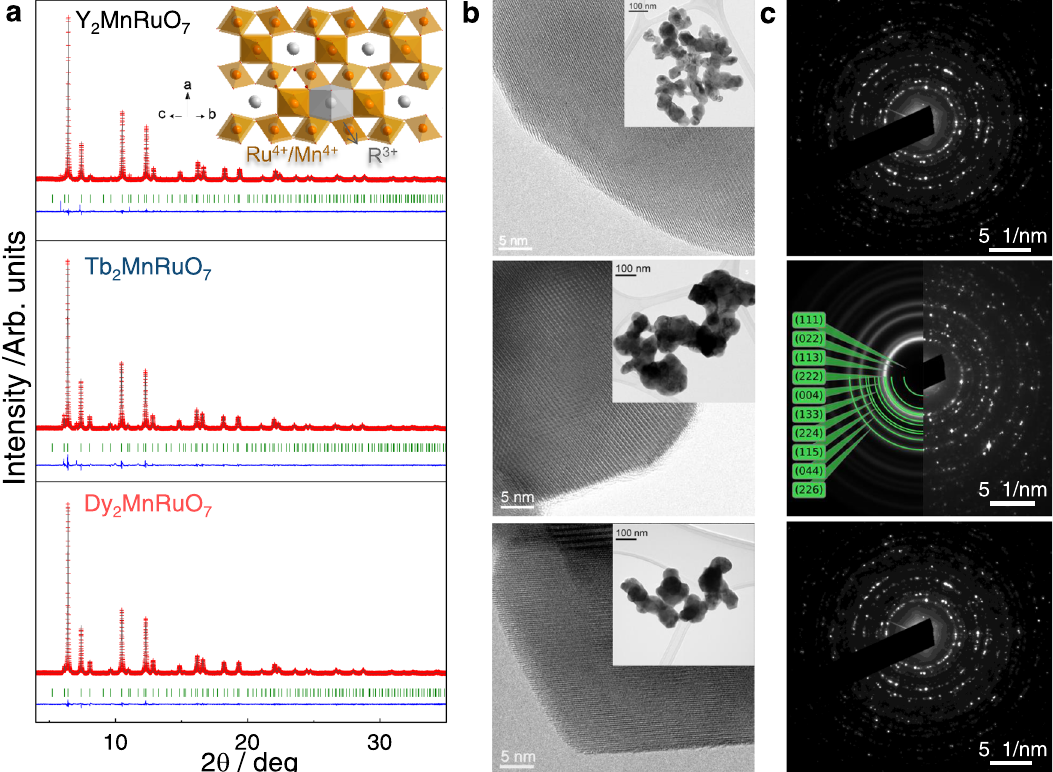
Fig. 1 | Morphological and structural characterization. a SXRD Rietveld analysis at room temperature of the pyrochlore structures. Inset: schematic view of the